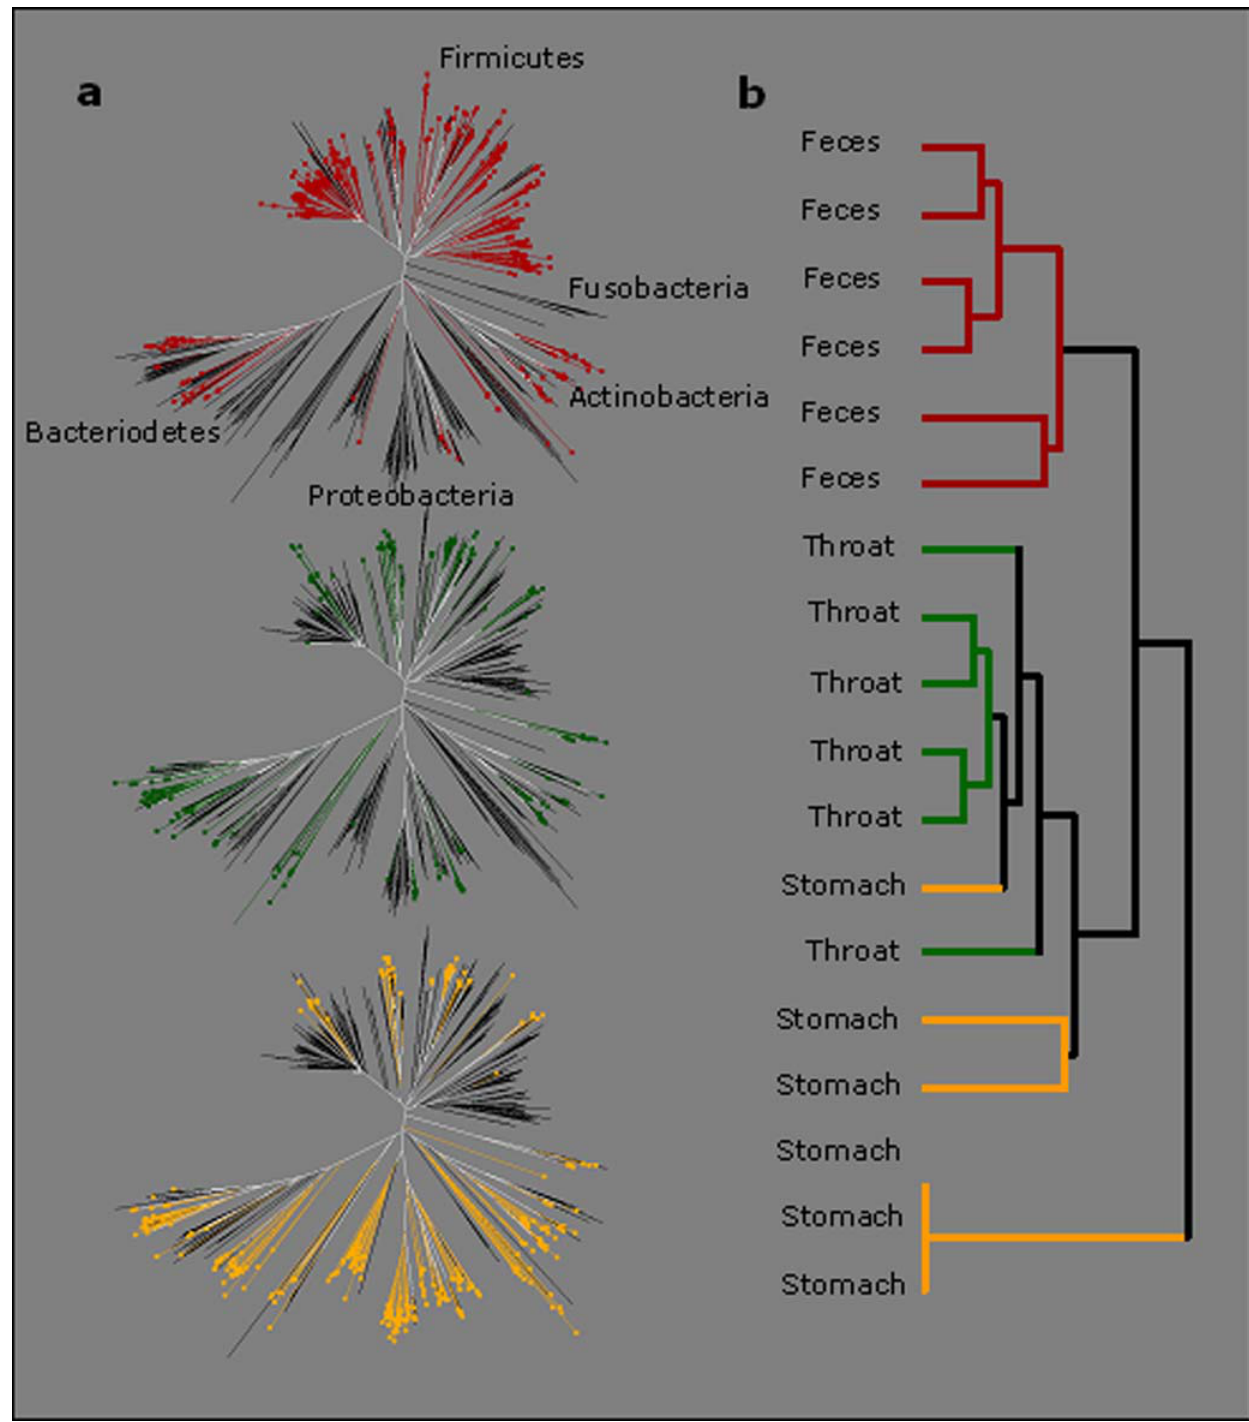
Figure 3. Comparison of the throat, stomach and fecal microbiotas. a, A neighbor joining phylogenetic tree of the RDP sequences representing the 454 reads from six samples of throat, stomach, and feces, respectively, was constructed. Branches in the tree represented in throat, stomach, and feces are labeled with green, yellow, and red, respectively. b, Hierchical clustering of the 18 samples based on how their reads were distributed within the tree using the weighted UniFrac metric [27] for pair wise comparisons of the samples. The lower three samples are H. pylori positive stomachs.